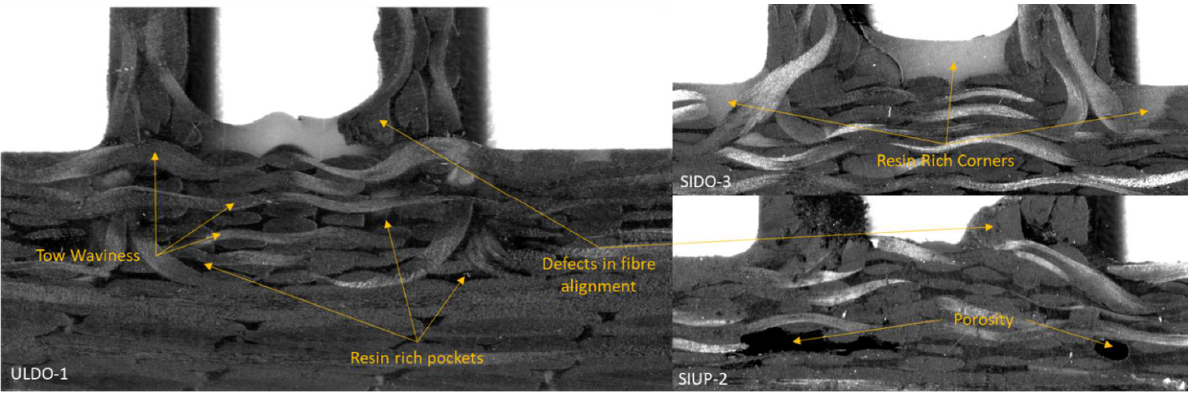
Across all parts, defects in fibre alignment were seen to different degrees. This was mostly prevalent at the inner base of the pi, where pinching of fibres in the upstanding pi legs was possible. Fibre pinching was more pronounced with rigid aluminium and UL- TEM ® inserts, whereas with a flexible insert, such as silicone, it was less common. This indicates it could have been caused by difficulty the during forming and tool loading pro- cesses, when the insert was loaded between the pi-legs and the outer aluminium blocks were closed around the preform. With the silicone insert, less force was required to load the preform into the tool and to demould the infused component. The insert could be stretched and pulled for both assembly and removal. The flexibility of the silicone resulted in easier assembly and manufacture, contributing to an improved forming quality in these components. Large zones of resin richness were observed in the corners and inner base of the pi- preforms. In addition to these large zones, there were smaller resin-rich pockets within each part. Due to the lighting, distinguishing resin richness and porosity was difficult in the scanned images. This was mitigated by cross-referencing the CT scans from the previ- ous work for each component. The analysis verified the cracking identified in the CT scans stemmed from resin rich areas identified in the images. Although resin rich pockets were observed across all parts, there was a higher presence of resin richness in the flow “down” configurations. The images also confirmed the higher resin richness of the ULUP/ULDO parts, as hypothesized in previous work analysing the CT scans. With the high-resolution images, fibre paths could be traced, and defects in align- ment within the different components were identified. In some parts, there was misalign- ment in the NCF where the pi was tooled, causing a curvature in the NCF ply. This was more common in the down infusions. Waviness and crimp was quantitatively evaluated through the control chart analysis. However, overall, the defects observed with this pro- cess demonstrate the need to establish a standardized process for documenting qualitative DfM rules, to eliminate unexpected sources of variation in manufacture in the tooling or process design stages.